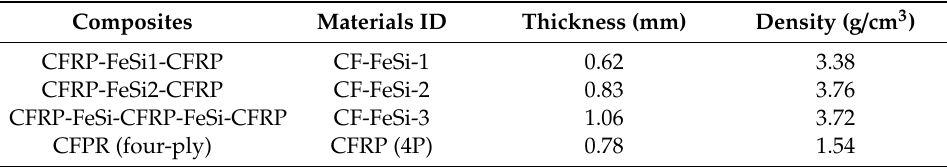
Table 2. Density and thickness of CFRP-FeSi composites.